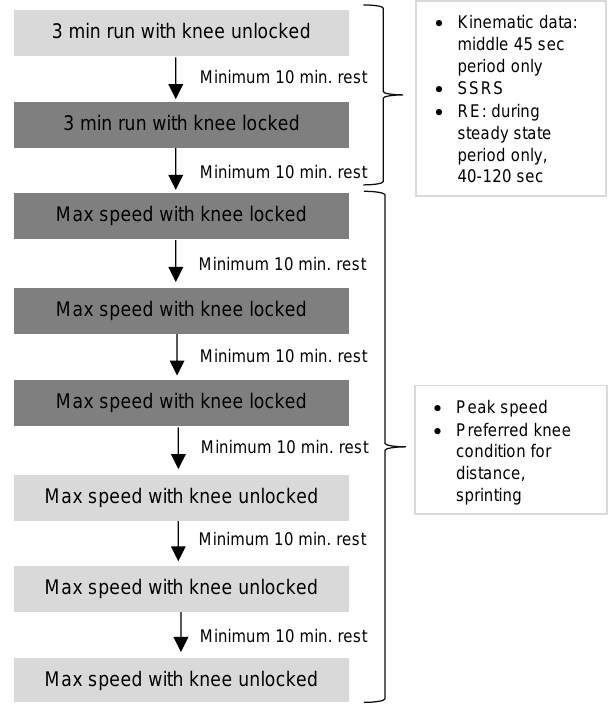
Figure 2 . A static trial was conducted for each subject and knee condition to define the local coordinate systems.